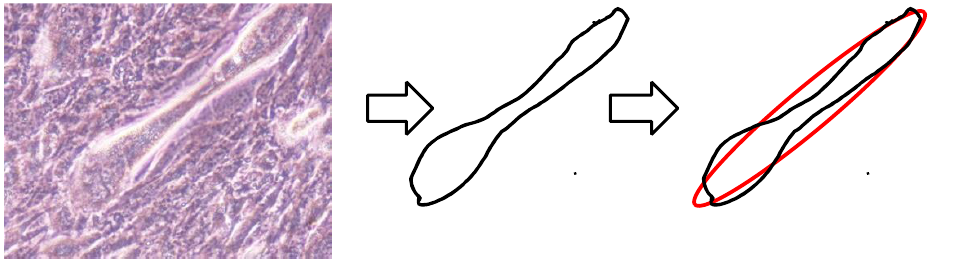
Figure 1. Measurement of major and minor axes of myotube-like cells using ellipse approximation.